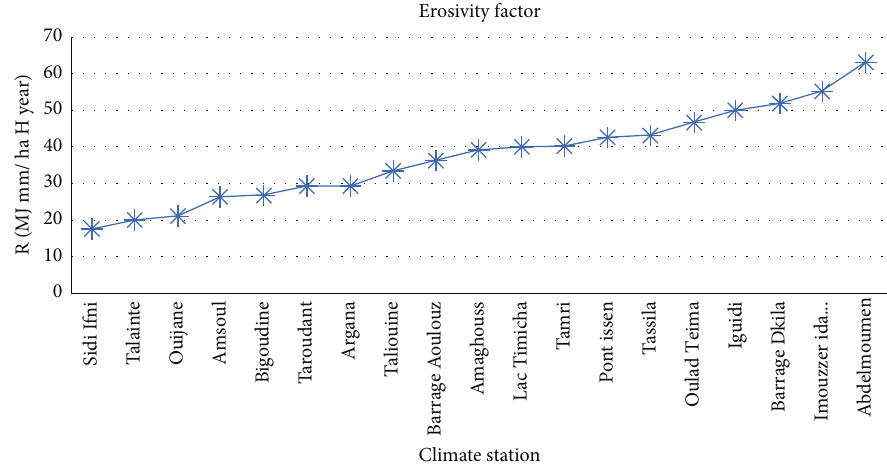
Figure 3: Rainfall aggressiveness (R) for the period 1970–2010 in the 19 meteorological